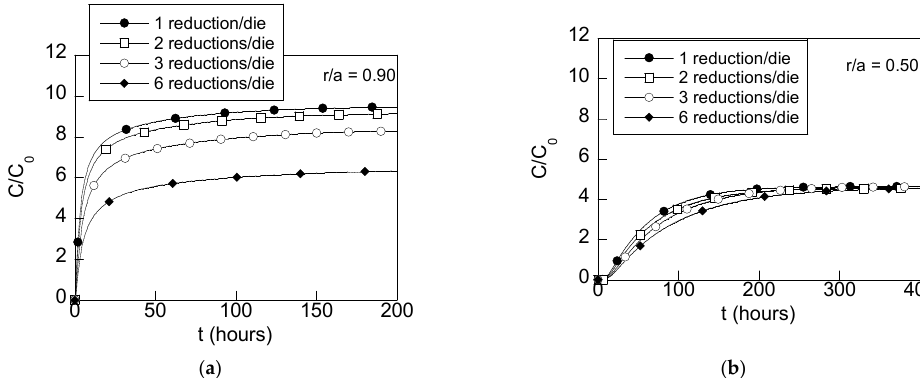
Figure 9. Time evolution of relative concentrations of hydrogen ( C / C 0 ) at two points placed at: ( a ) r / a = 0.90, ( b ) r / a = 0.50.